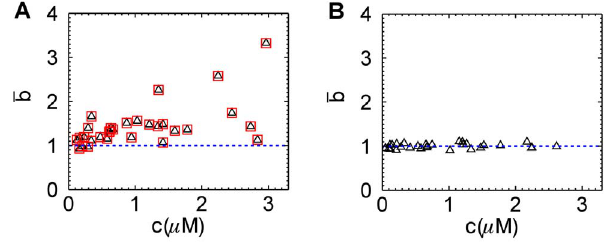
Figure 1. Normalized brightness of EGFP versus concentration. (A) EGFP in yeast cells results in brightness values that scatter from 1 to 3. Brightness is analyzed by PCH analysis (triangles) and by moment analysis (squares). (B) EGFP in U2OS cells exhibits a brightness close to 1 at all concentrations as expected for a monomeric protein. The blue dashed line represents the brightness value expected for monomeric EGFP.